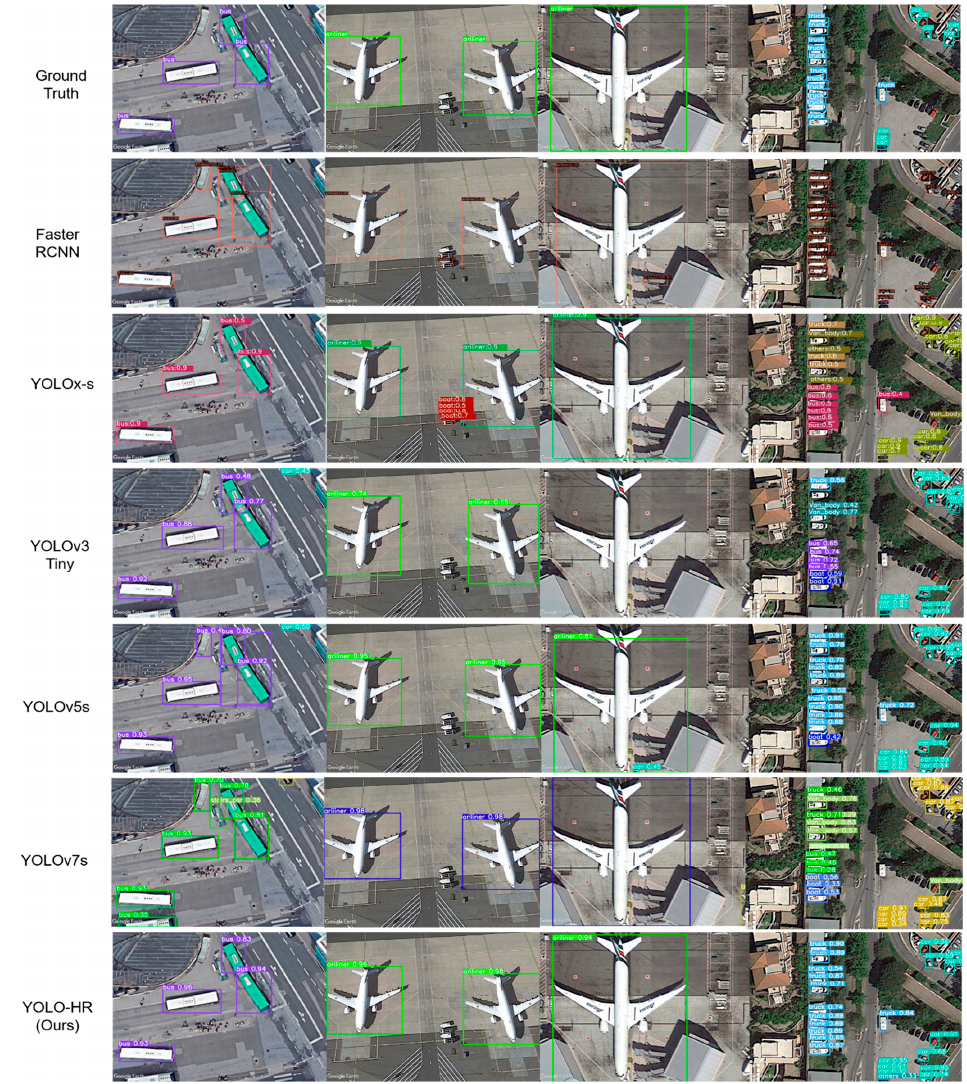
Figure 7. Comparison of the detection effect of different model detection parts.